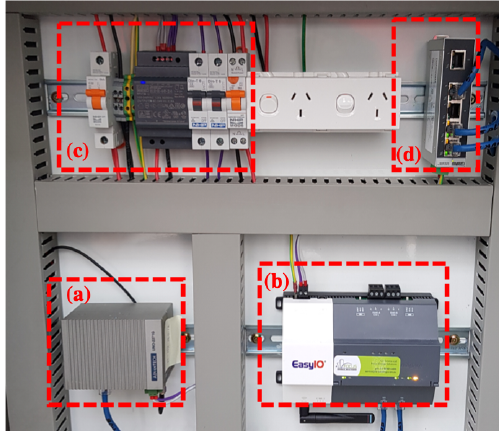
Figure 6. Physical installation of the integration design for a building distributed energy resource